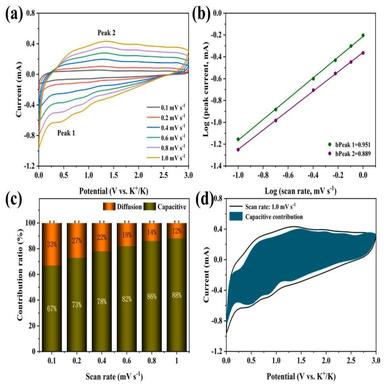
FeSnSe/SCNFs-1 electrode (a) CV curves at 0.1 to 1.0 mV s − 1 sweep rates; (b) linear relationship between the corresponding log ip-log (v); (c) diffusive contribution versus pseudocapacitive contribution histograms at various sweep rates; (d) pseudocapacitive contribution CV curves at 1.0 mV s − 1 sweep rate.